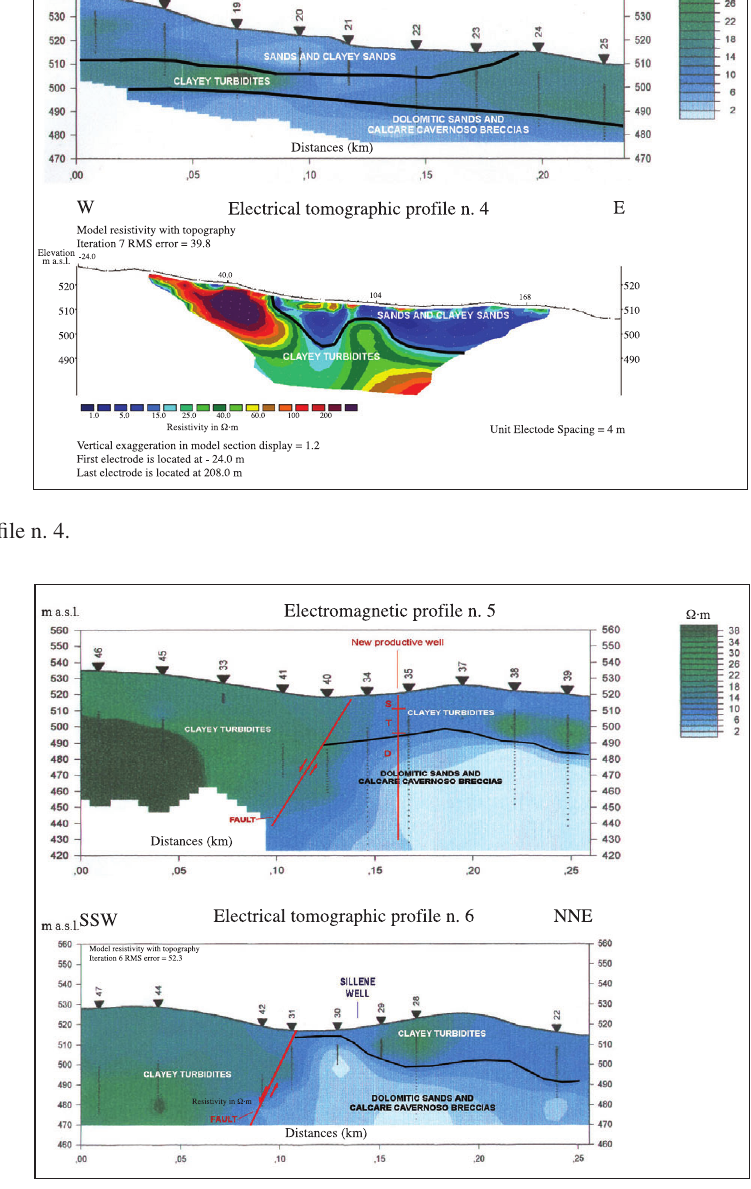
Fig. 9. Profiles n. 5 and